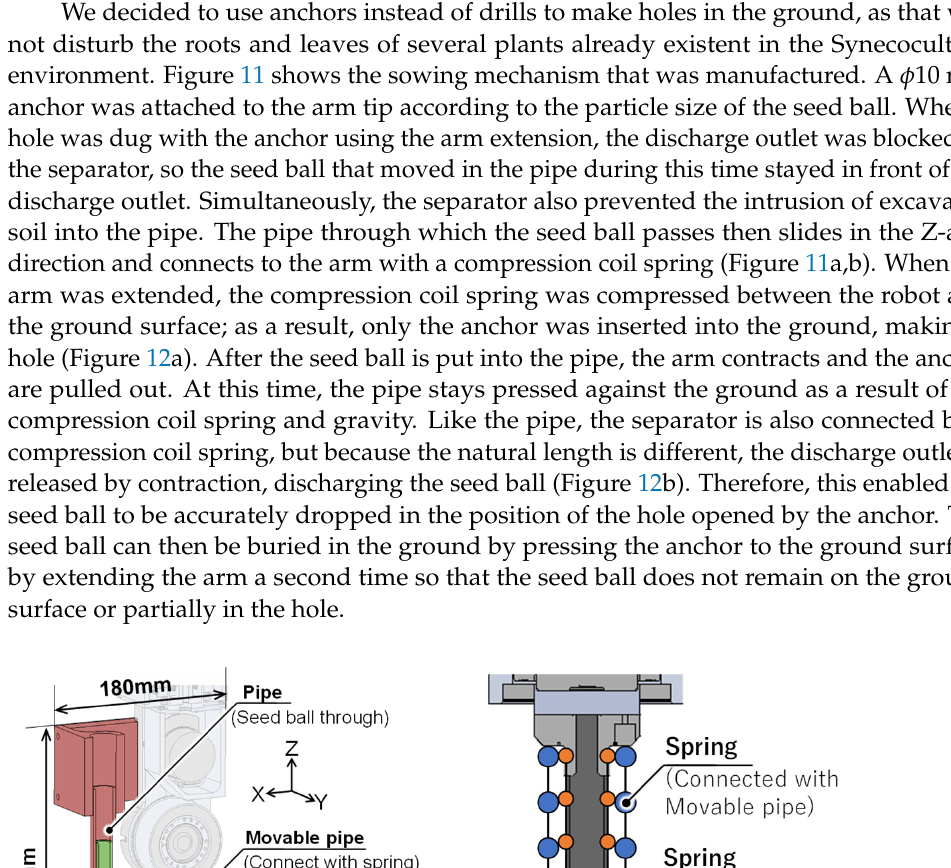
Figure 11. ( a ) Whole parts, ( b ) Anchor and separator. Schematic view of a sowing mechanism.